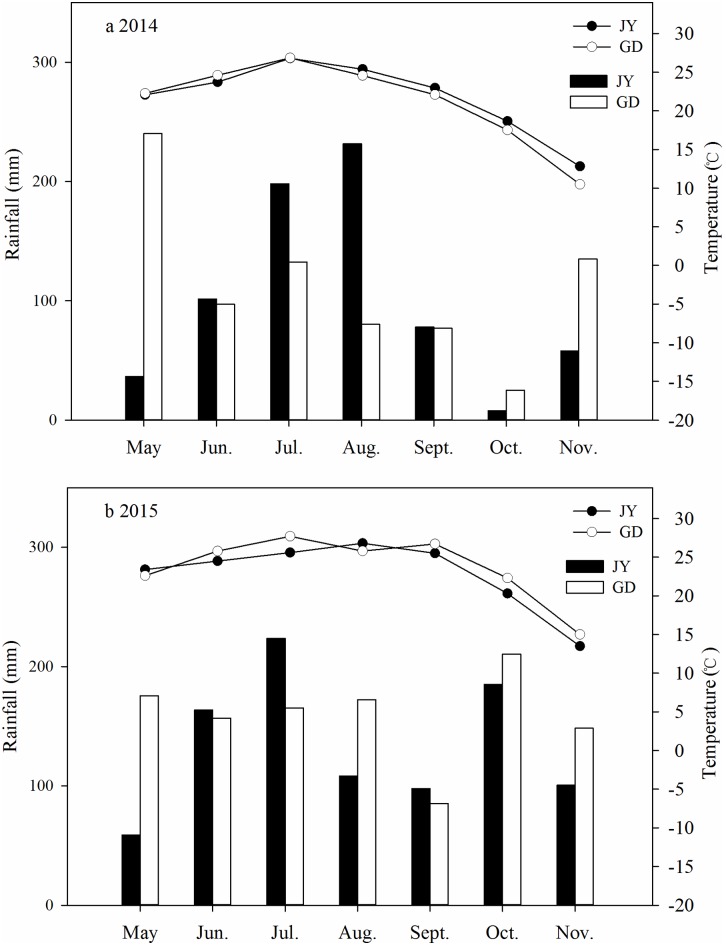
Rainfall (bars) and average temperatures (lines) in Guangde (GD) and Jiangyan (JY) from May to November during 2014 (a) and 2015 (b).